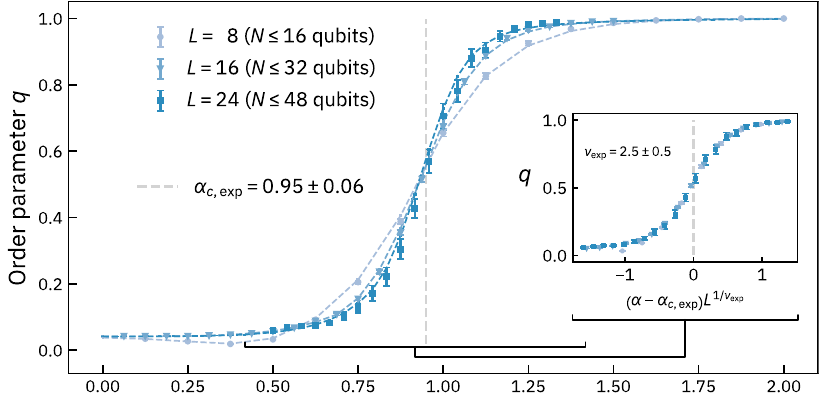
Fig. 3 | Experimental results for the order parameter q as a function of mea- surement ratio α , using the ibm_washington , ibmq_brooklyn and ibm_hanoi quantum processors 24 . Each data point represents an average of the order para- meterover900matrices B M , except for L =24,whereweaverageover50matrices. Error bars indicate the standard error of the mean. We study system sizes L =8 (light blue circles), L =16 (medium blue triangles), and L =24 (dark blue squares).